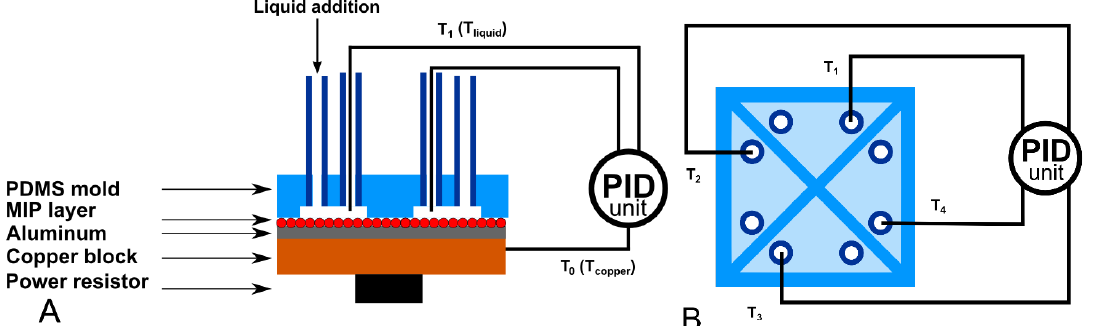
Figure 2. Schematic side view ( A ) and top view ( B ) of the PDMS flow cell and the four thermocouples. The temperature of the copper, T , is strictly controlled. The temperature 0 of the liquid (T ) in each quadrant is solely 1,2,3,4